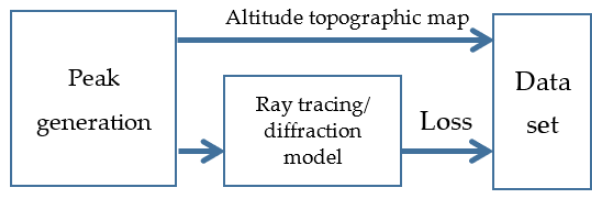
Figure 2. Data set Figure 2. Data set generation. Figure 2. Data set generation.